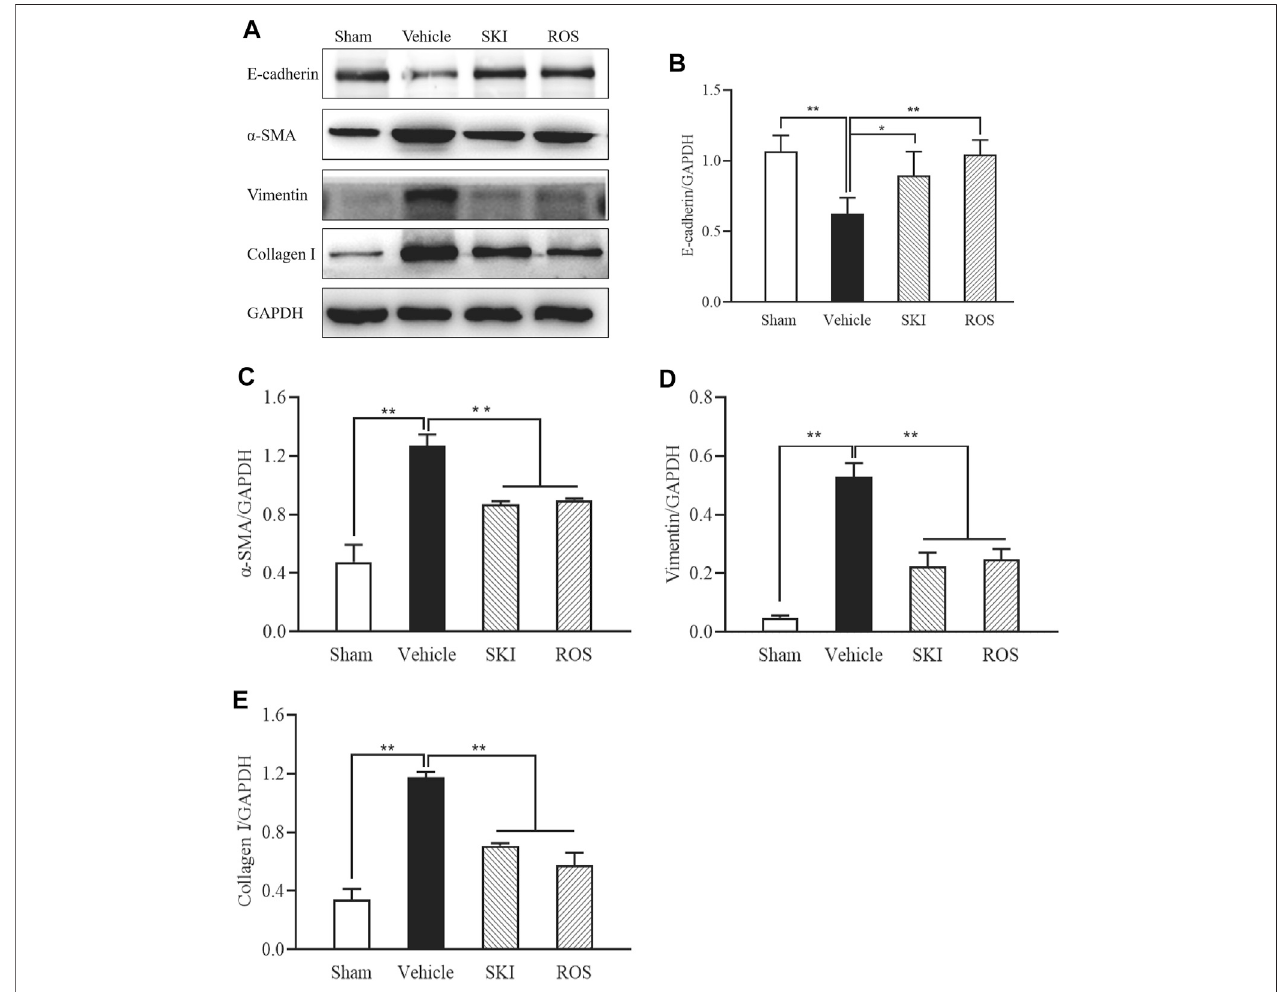
FIGURE7| TheeffectsofSKIandROSontheproteinexpressionlevelsofE-cadherin, α -SMA,vimentin,andcollagenI, invivo . (A) WBanalysisof α -SMA,vimentin, and collagen I, in the kidney; (B – E) The rate of α -SMA, vimentin, and collagen I to GAPDH, respectively. Data are expressed as mean ± S.E. ** p < 0.01. Abbreviations: α -SMA, α -smoothmuscleactin;collagenI,collagentypeI;WB,Westernblot;GAPDH,glyceraldehyde-3-phosphatedehydrogenaseROS,rosiglitazone;SKI,Shenkang